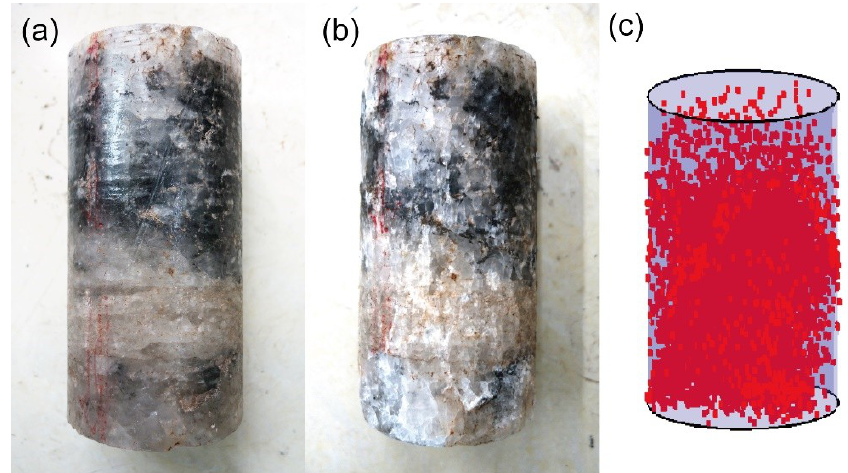
Figure 3. Comparison of rock salt failure characteristics: ( a ) picture of rock salt before test; ( b ) picture of rock salt after triaxial loading test; and, ( c ) AE locations of rock salt under triaxial loading test.